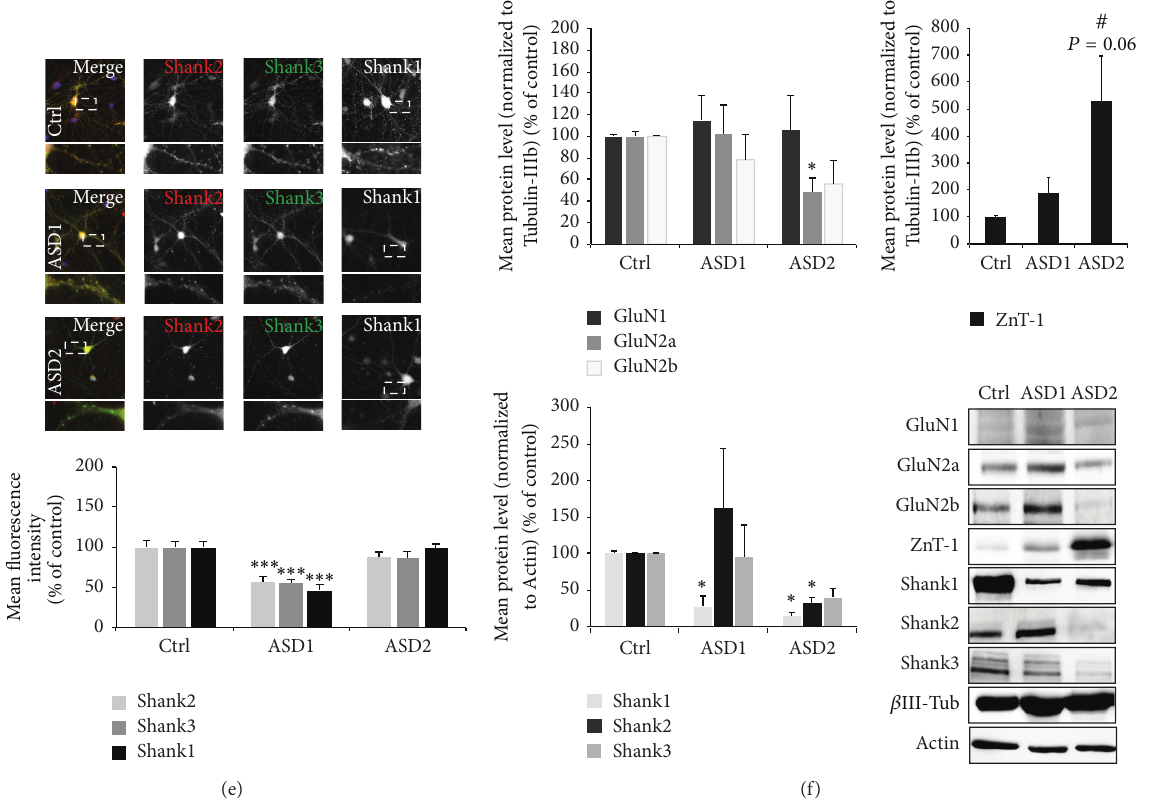
Figure 3: An ASD biometal profile affects cell health and synapse numbers in vitro . (a) Hippocampal neurons were grown from DIV 10 to DIV 14 in cell culture media containing different sets of trace metals: control cells (Ctrl) were grown in Neurobasal medium. ASD1 cells were grown in Neurobasal medium with addition of putative toxic metals (0.5 𝜇 M Cd, Cu, Hg, and 2 𝜇 M Pb). ASD2 cells were grown in trace metal depleted Neurobasal medium that was reconstituted only for Mg and Ca, with addition of the putative toxic metals (0.5 𝜇 M Cd, Cu, Hg, and 2 𝜇 M Pb). The amount of cell death was calculated assessing the number of neuronal apoptotic nuclei (identified by MAP2 and DAPI staining) per optic field (from 5 fields of view) normalized against the total number of neurons per optic field. A significant reduction in cell health can be observed in cells deficient in Fe and Zn and subjected to toxic metals (ASD2). (b) The number of primary, secondary, and tertiary dendrites was investigated from 10 cells per condition. Cells were stained with MAP2 antibody. As signs of cell death, neurons show fragmentation (pinching off) dendrites, starting with branches more distal from the soma. Dendrites showing signs of fragmentation were not counted. Corresponding to the increase in cell death, neurons growing under ASD2 conditions showed significantly increased signs of dendriticfragmentation.(c)SynapseswerelabeledusingBassoonandHomer1b/cfluorescenceandthenumberofimmunoreactivepunctawas measured per 10 𝜇 m dendrite length on primary dendrites (3 dendrites per cell, 10 cells in total per group). Merged images show additional staining of nuclei using DAPI (cyan) and MAP2 (blue). A significant reduction can be seen in cells growing in medium resembling the biometal profile found in ASD patients (ASD2). (d) Expression levels of NMDA receptor subunits (GluN1, GluN2a, and GluN2b) and SHANK genes (Shank1, Shank2, and Shank3) were measured by qRT-PCR. Virtual mRNA concentrations are shown averaging from three replicates and normalized against HMBS. A significant decrease of GluN1 and GluN2a mRNA expression levels can be seen in cells grown under ASD2 conditions. Under ASD1 conditions, GluN2b levels significantly increase. A significant reduction in gene expression levels can also be observed in Shank family members under ASD2 conditions, which is significant for Shank1, Shank2, and Shank3. (e) Immunocytochemistry of hippocampal neurons DIV 14 grown under control, ASD1, and ASD2 conditions. The fluorescence intensity of Shank positive puncta was measured using antibodies specific for Shank1, Shank2, and Shank3. Exemplary images (upper panel) and quantification of average puncta signal intensity of 10 cells per condition (lower panel). Merged images show additional DAPI staining of the nucleus. Neurons grown under ASD1 conditions show a significant decrease of synaptic Shank proteins, while neurons under ASD2 conditions did not show a reduction. (f) Analysis of protein expression levels in synaptic (P2) fractions of NMDAR subunits, proteins of the Shank family, and ZnT-1 from three independent experiments normalized against 𝛽 -III-tubulinoractin. Neurons grown inASD2 medium showasignificant reduction of GluN2a receptor subunits and a trend towards a decrease of GluN2b. In contrast, synaptic ZnT-1 shows a strong upregulation. The expression of Shank family members is reduced under ASD2 conditions (lower left panel). The reduction is significant for Shank1 and Shank2 and seen as a clear trend for Shank3. Exemplary bands are shown in the lower right